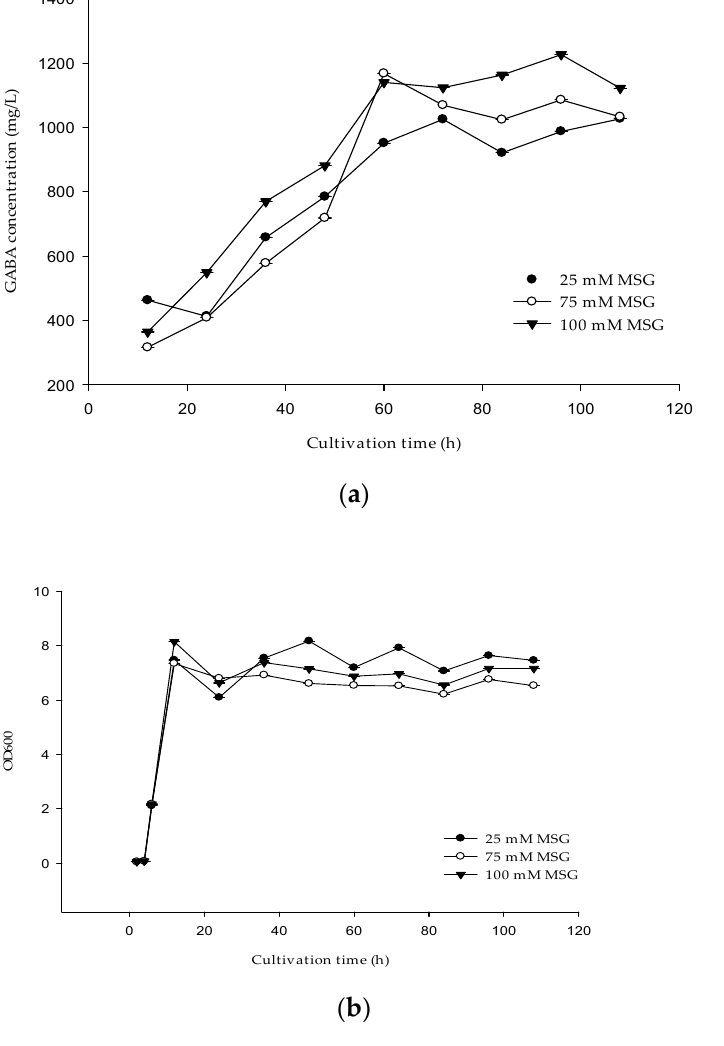
Figure 5. Effect of various MSG concentrations on ( a ) GABA production and ( b ) the growth of L. plantarum FNCC 260 cultivated in MRS medium at 37 °C. Data expressed as mean ±SD with SD less than 5%. The experiments were conducted at least in duplicates.